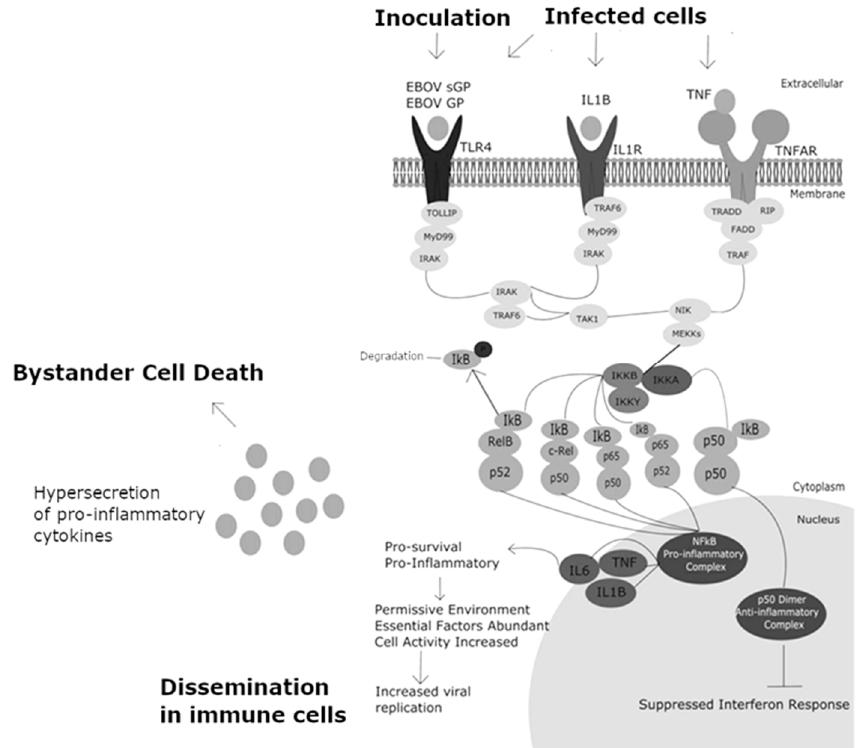
Figure 7. Schematic diagram of the hypothesised model of the relationship between EBOV infection and NF κ B activation. Activation occurs via stimulation of multiple receptors, including TLR4 (by EBOV sGP / GP), IL1R by IL1 β , and TNFR by TNF. Heterodimeric complexes composed of p65, p50, 052, c-Rel, RelB are pro-inflammatory, homodimers may also form from p50–p50. P50 homodimers are anti-inflammatory and act as a negative feedback system controlling NF κ B pro-inflammatory activation. P50 homodimers suppress the interferon response, and the activity of the EBOV proteins VP24 and VP35 further contribute to rendering the type 1 interferon response ine ff ective. Pro-inflammatory proteins are produced, and NF κ B heterodimers result in pro-survival signalling, preventing apoptosis. Increased cellular activity and upregulation of as yet unidentified host factors result in increased viral replication rates, and improved permissiveness for viral infection.